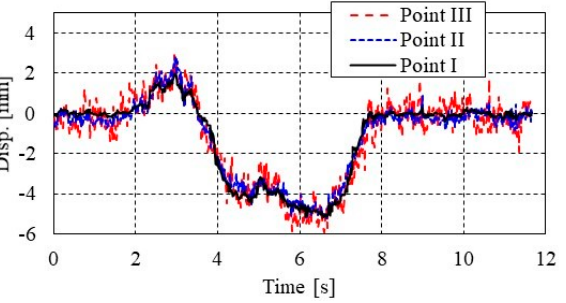
Figure 24. Effect of contrast in the measurement subset on image processing (bridge B). Table 10. Errors (2 σ value) of each measurement subset position with different contrasts.